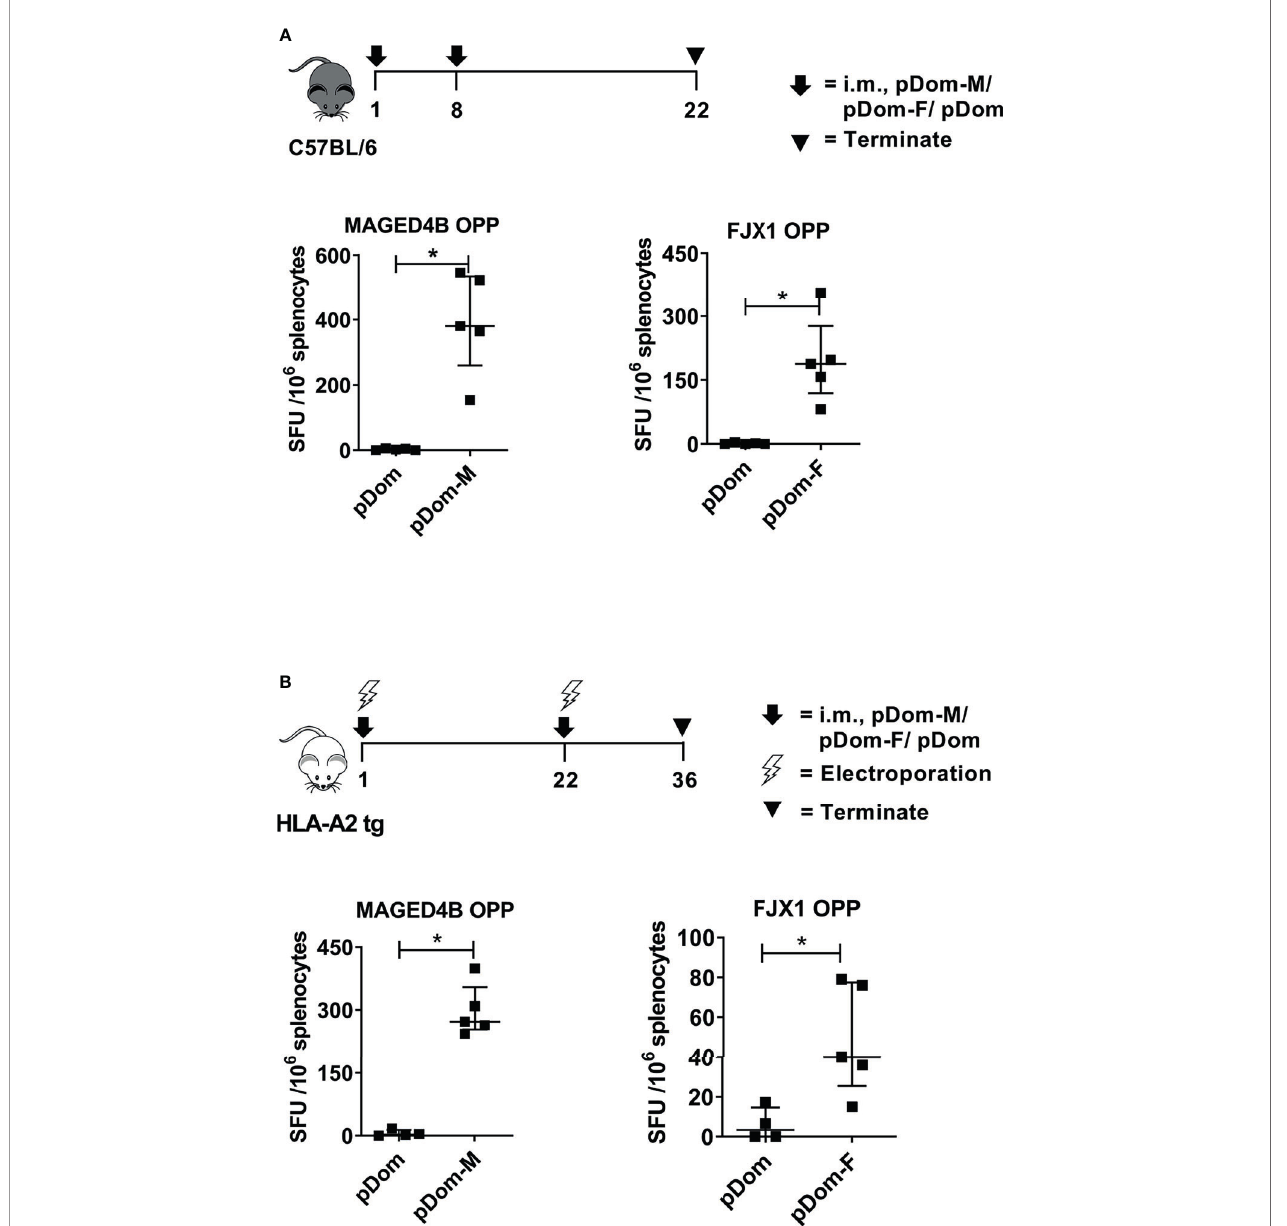
FIGURE 2 | pDom-M and pDom-F vaccines are immunogenic in wildtype C57BL/6 and transgenic HLA-A2 mice. Augmentation of antigen-speci fi c immune responses was observed in all mice that received pDom-M or pDom-F in comparison to mice which received pDom control. (A) C57BL/6 mice were vaccinated at day 1 and day 8 with pDom, pDom-M, or pDom-F. Splenocytes were harvested at day 22 to study antigen-speci fi c immune responses by IFN g ELISpot. (B) HLA-A2 tg mice were vaccinated at day 1 and day 22 with electroporation. Splenocytes were harvested at day 36 for IFN g ELISpot. Splenocytes were seeded at 2.5 x10 5 to ELISpot plates and stimulated overnight with 1 µM of MAGED4B OPP or FJX1 OPP. All data are expressed as mean ± SD. (* p -value <